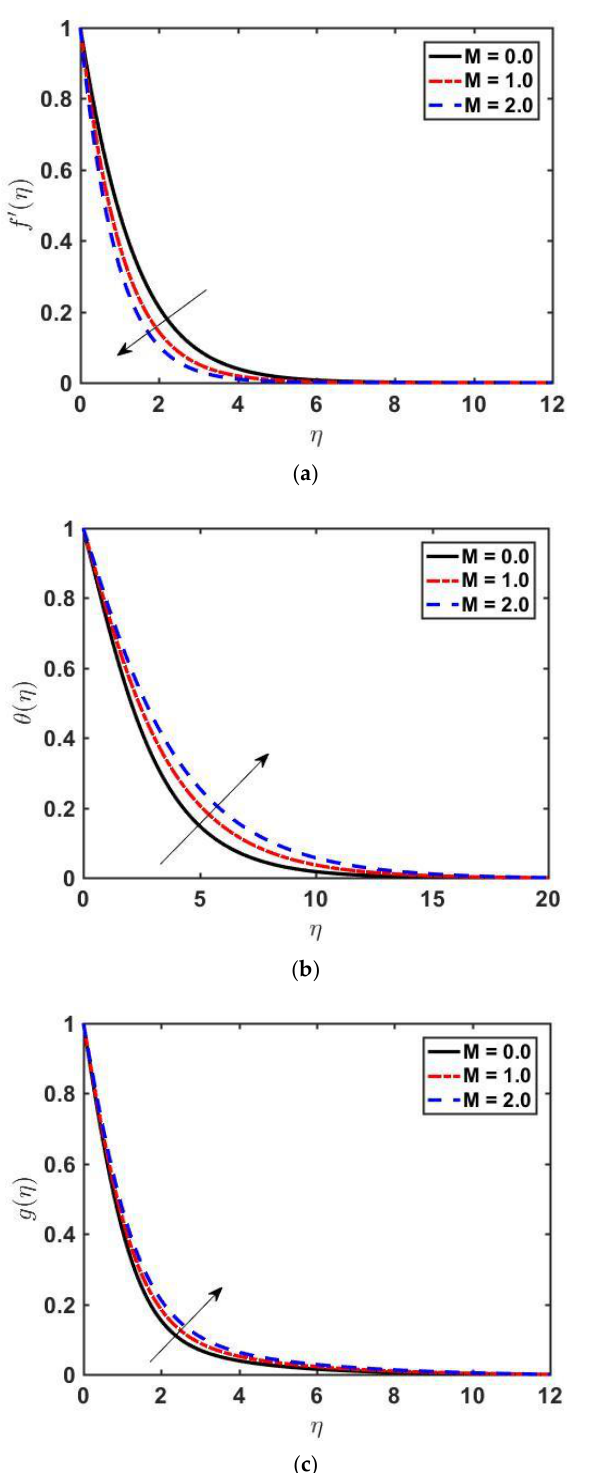
Figure 3. Profiles of f’(η), 𝜃(𝜂), and 𝑔(𝜂) versus 𝜂 for various values of 𝑀, fixing 𝜆 = 0.3, 𝑃𝑟 = 0.5, 𝐿𝑒 = 3.0, 𝑁𝑏𝑡 = 2.0, 𝑁𝑐 = 0.5, and 𝑆𝑐 = 2.0.